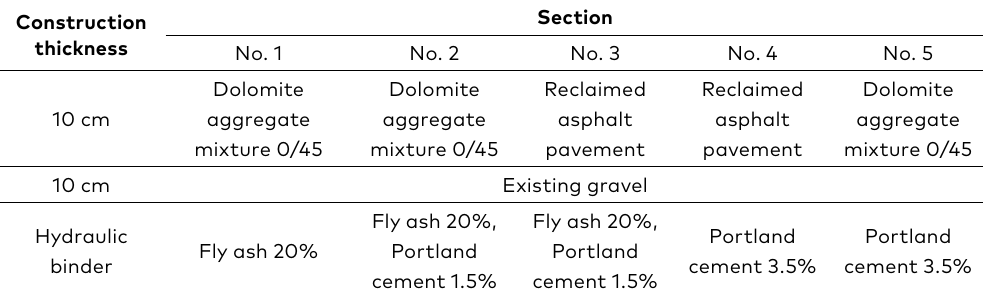
Table 2. Composition in five different sections in the pilot project